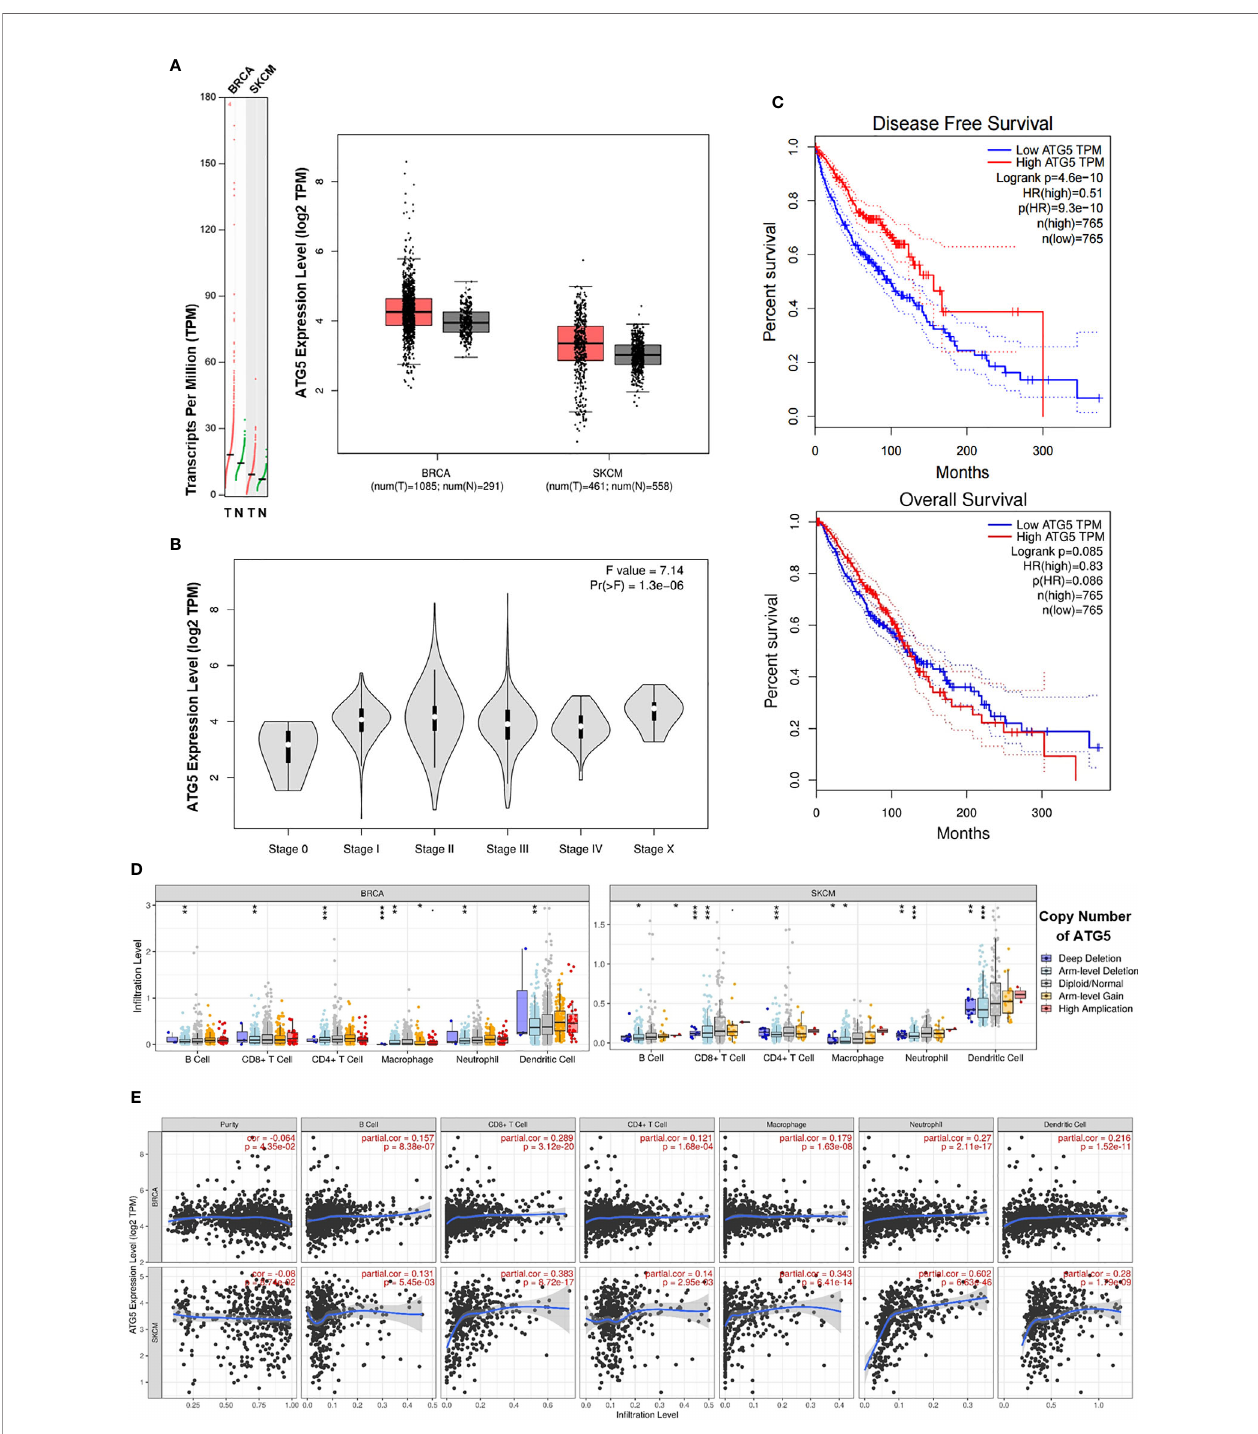
FIGURE 7 | Bioinformatic analysis of the expression of the autophagy biomarker ATG5 and the relationship between ATG5 and immune in fi ltration levels in BRCA and SKCM. (A) The ATG5 mRNA (left panel) and protein expression (right panel) levels were higher in BRCA and SKCM tissue than in normal tissue. (B) ATG5 expression levels in different clinical stages in BRCA and SKCM patients. (C) Kaplan – Meier survival curves of disease-free survival (upper panel) and overall survival (lower panel) for high and low ATG5 expression groups in BRCA and SKCM patients. (D) A comparison of immune in fi ltration levels among BRCA (left panel) and SKCM (right panel) tumors with different ATG5 gene copy number status. (E) The correlation between ATG5 expression and the abundance of six types of immune cells (B cells, CD8 + T cells, CD4 + T cells, macrophages, neutrophils, and dendritic cells) in BRCA (upper panel) and SKCM tissues (lower panel). BRCA, breast invasive carcinoma; SKCM, skin cutaneous melanoma. * P < 0.05, ** P < 0.01, *** P <